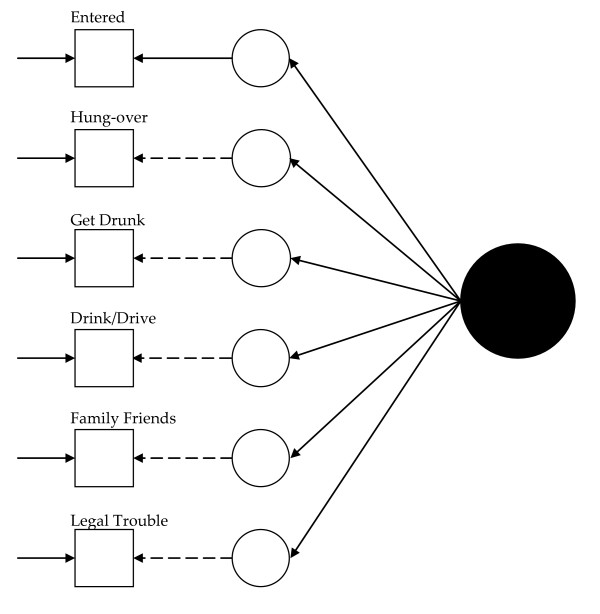
Path diagram summarizing Model 2, the 1992 alcohol abuse measurement model constraining the loadings to equality across groups. The solid black circle represents the alcohol abuse variable. The small circles represent the continuous latent response variates underlying the dichotomous items (represented by the squares). The arrows from the solid black circle to the smaller circles represent the loadings. The arrows from the small circles to the squares represent the thresholds. The arrows pointing only to the squares represent the uniquenesses. Solid lines represent values constrained to equality across non-Hispanic Caucasians and Hispanics. Dashed lines represent values freely estimated across non-Hispanic Caucasians and Hispanics.